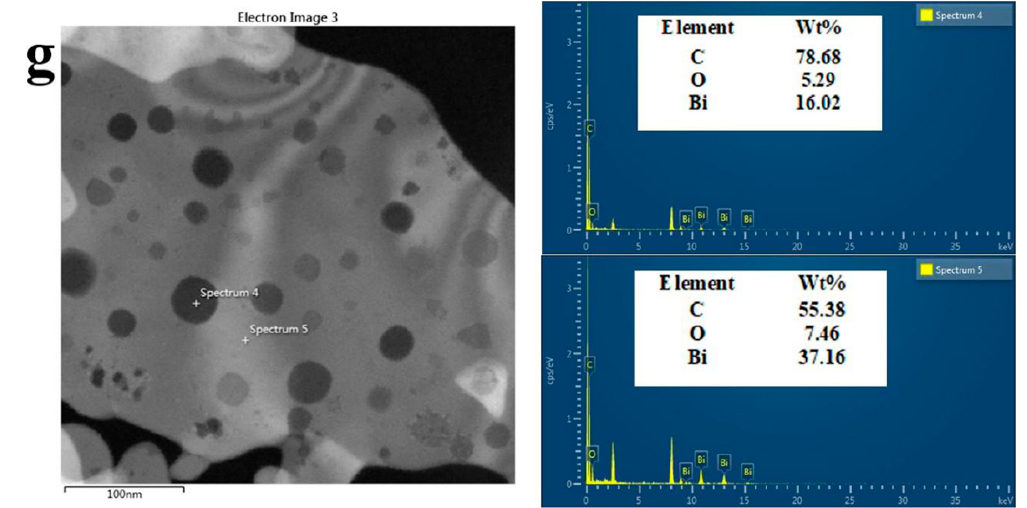
Figure 3. Element mapping images ( a – d ), HRTEM images ( e , f ) and EDS spectrum ( g ) of BOC-CQD-15.